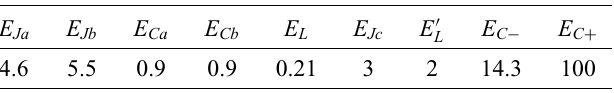
TABLE I. The circuit parameters in h GHz used throughout this